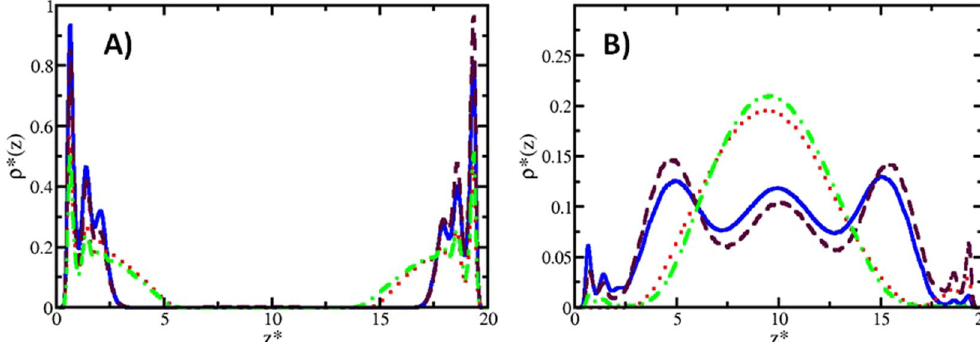
Figure 6. Density profiles of heptane before and after the desorption process by means of nonionic and ionic surfactants. The red and blue lines correspond to the cases when long and short nonionic surfactants were used, respectively; the green and burgundy lines correspond to the cases for long and short ionic surfactants, respectively. Note that the density profiles of the surfactants are not shown, to improve the clarity of the figures. ( A ) Density profiles before the desorption process of HC occurs. These profiles were obtained for a nonionic surfactant concentration equal to 0.02 (red and blue lines), and equal to 0.03 for the case of ionic surfactants (green and burgundy lines). These are the threshold values of the concentration at which desorption begins to occur, see also Fig. 5. ( B ) Density profiles after desorption of HC. These profiles were obtained for a concentration of 0.04 of long nonionic surfactants, and of 0.08 for the case of short non-ionic surfactants (see Fig. 5(A)). The profiles for ionic surfactants correspond to a concentration of 0.06 for long chains and 0.08 for the case of short chains (see Fig. 5(B)). All quantities are reported in reduced DPD units.